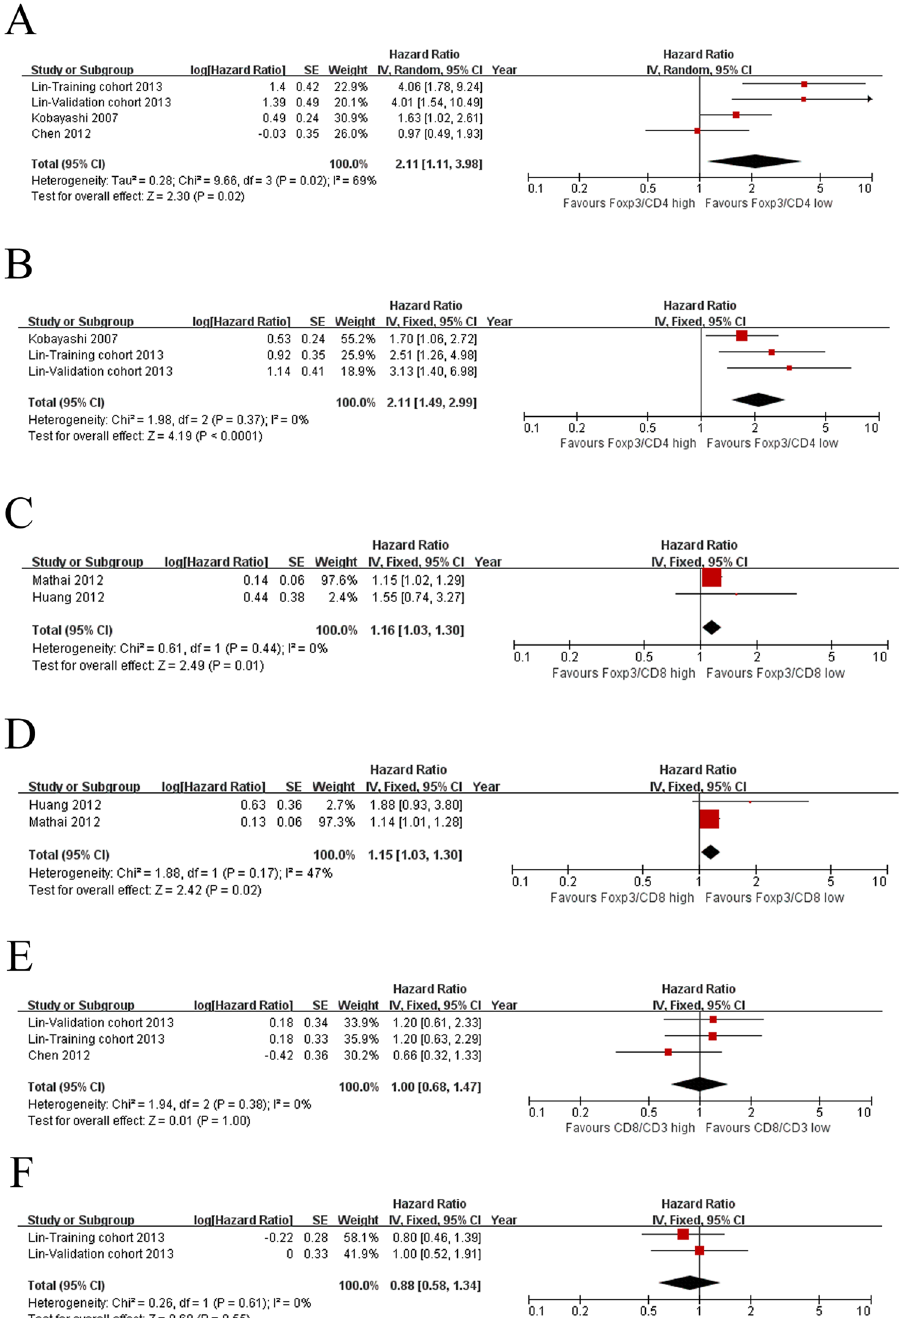
Figure 3. Forest plots of relationships between the Foxp3 + /CD4 + ratio, Foxp3 + /CD8 + ratio, CD8 + /CD3 + ratio and survival. ( A ) The effect of the Foxp3 + /CD4 + ratio on OS. ( B ) The effect of the Foxp3 + /CD4 + ratio on DFS/ RFS. ( C ) The effect of the Foxp3 + /CD8 + ratio on OS. ( D ) The effect of the Foxp3 + /CD8 + ratio on DFS/RFS. ( E ) The effect of the CD8 + /CD3 + ratio on OS. ( F ) The effect of the CD8 + /CD3 + ratio on